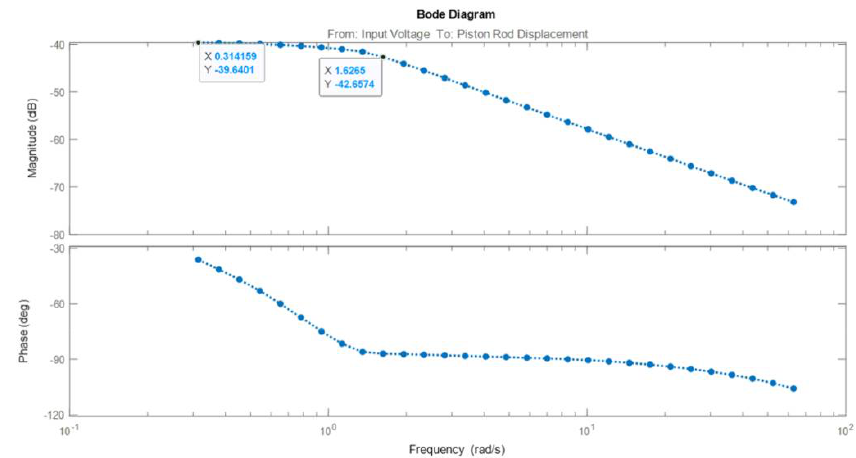
Figure 9. The pneumatic system estimated frequency response.